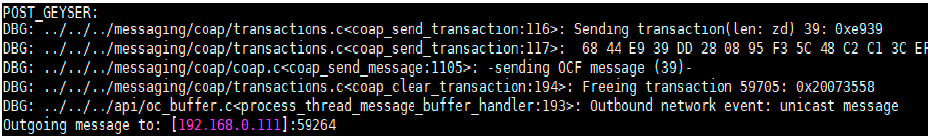
Figure 10. Energy consumption monitoring on IotSmartApp .